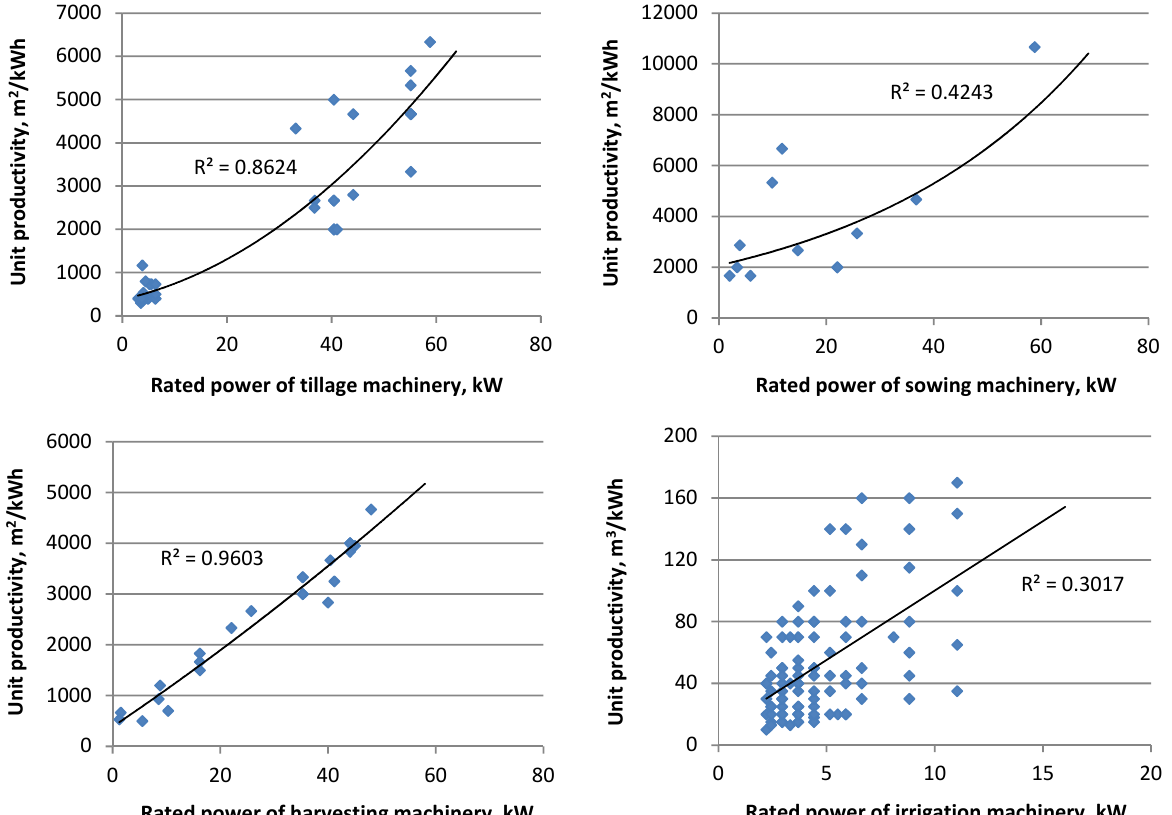
Figure 4. Fitting curves of the unit